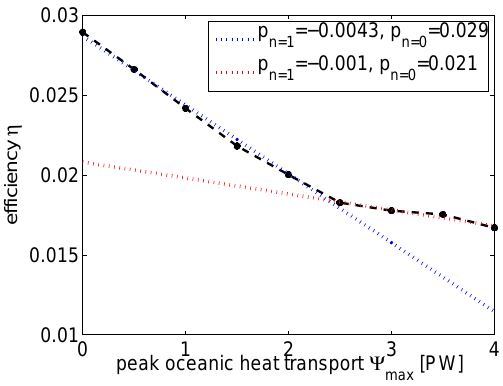
Figure 8. Time average of efficiency η for steady state ob- tained for varying oceanic heat transport. Dotted line represents best linear fit for (i) 0.0PW ≤ OHT max ≤ 2.5PW (blue) and for (ii) 2.5PW ≤ OHT max ≤ 4.0PW (red) with polynomial coefficients of n th order, p n = 1 and p n = 0 .